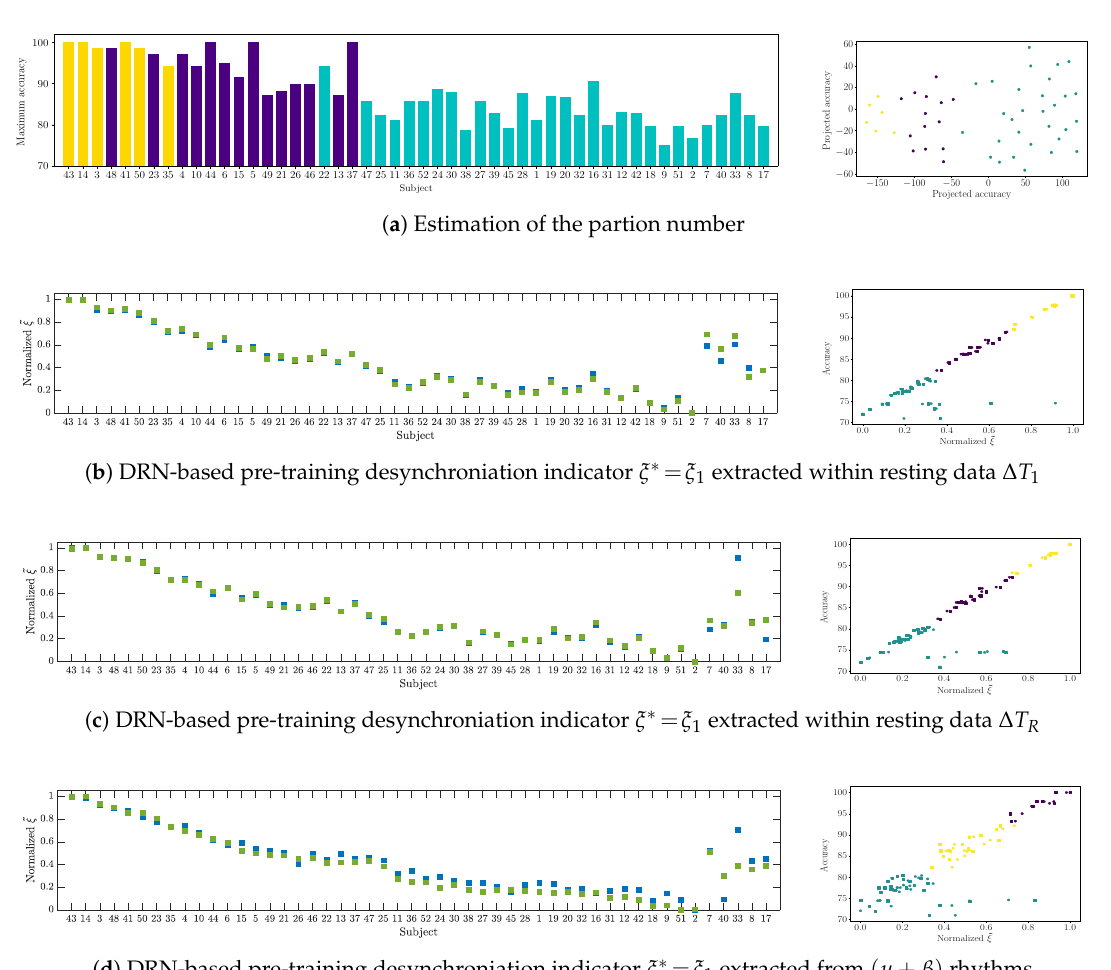
Figure 9. Extracted assessments using the proposed DRN estimator (left-side column) and performed clustering of subjects (right-side